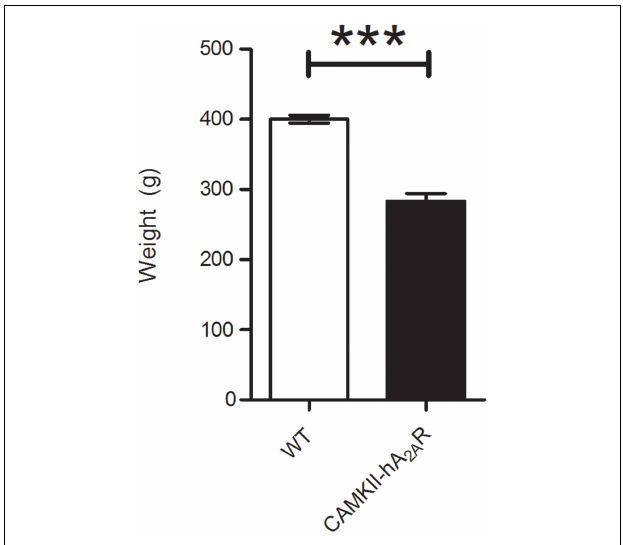
FIGURE 2 |Weight control ofTg(CaMKII-hA2AR) animals . Results are expressed as mean ± SEM. *** p < 0.001WT: n = 12;Tg(CaMKII-hA2AR): n =